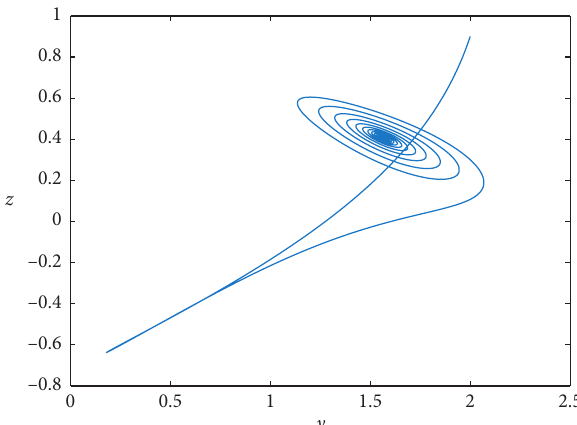
Figure 11: Dynamic behavior of fractional financial chaotic model with α � 0 . 95.